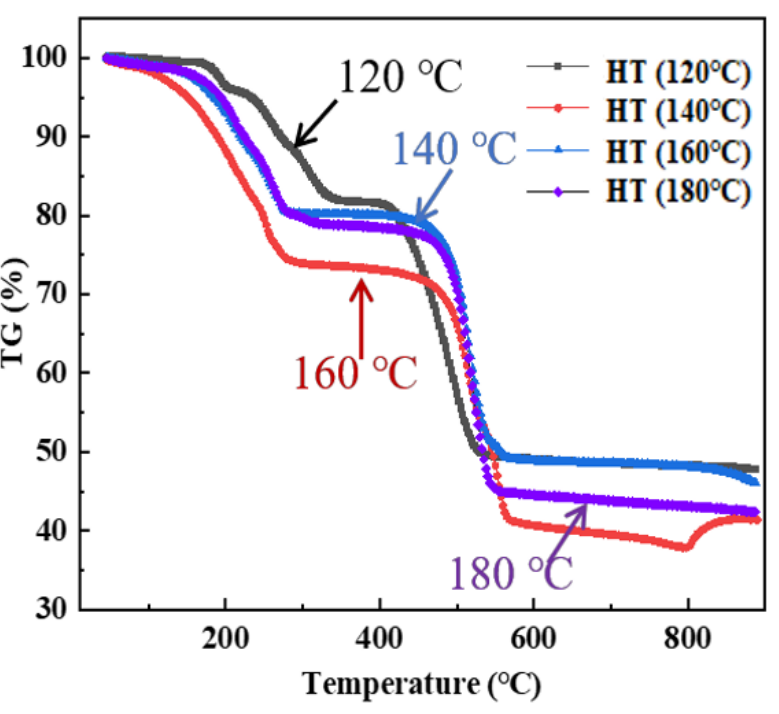
Figure 3. TG curves of MOF-5 prepared by different hydrothermal temperatures.